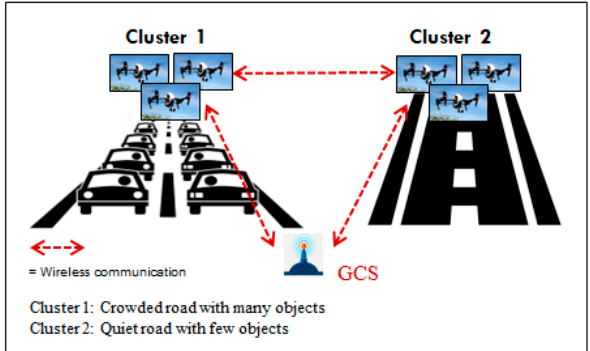
Figure 1. Drone clusters with identical service but different environmental conditions. GCS: Ground Control Station.